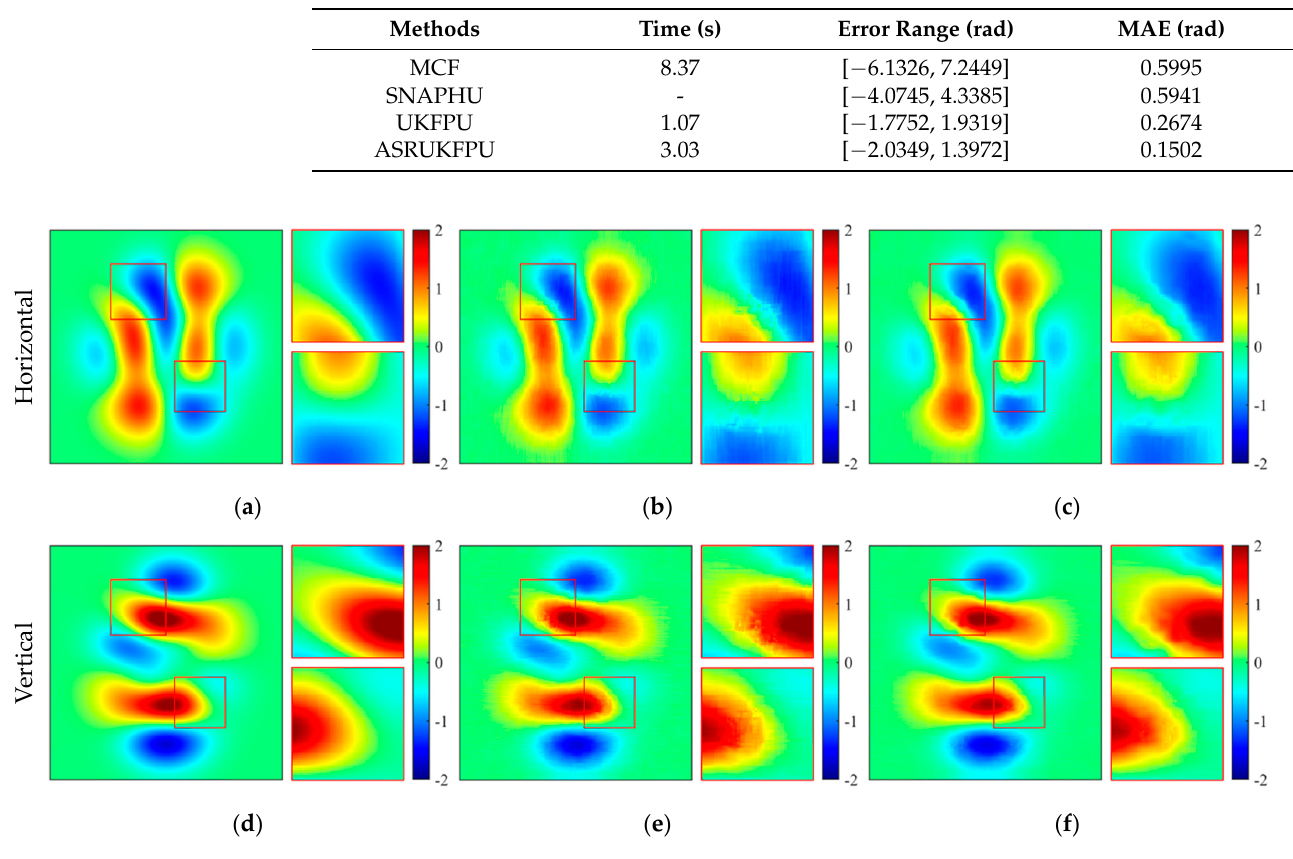
Figure 5. PGE results (unit is rad). ( a ) PGE results of the simulated noise-free interferogram in the horizontal direction. ( b ) PGE results of the simulated noisy interferogram in the horizontal direction by using the modified PGE method, but the continuity detection and the revision of outliers are not carried out. ( c ) PGE results after revision for outliers in the horizontal direction. ( d ) PGE results of the simulated noise-free interferogram in the vertical direction. ( e ) PGE results in the vertical direction corresponding to ( b ). ( f ) PGE results after revision for outliers in the vertical direction.